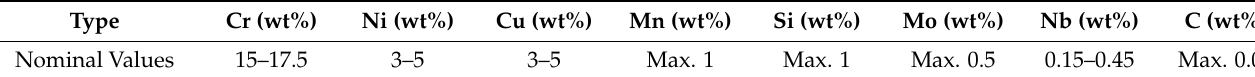
Table 1. Metal powder chemical composition.